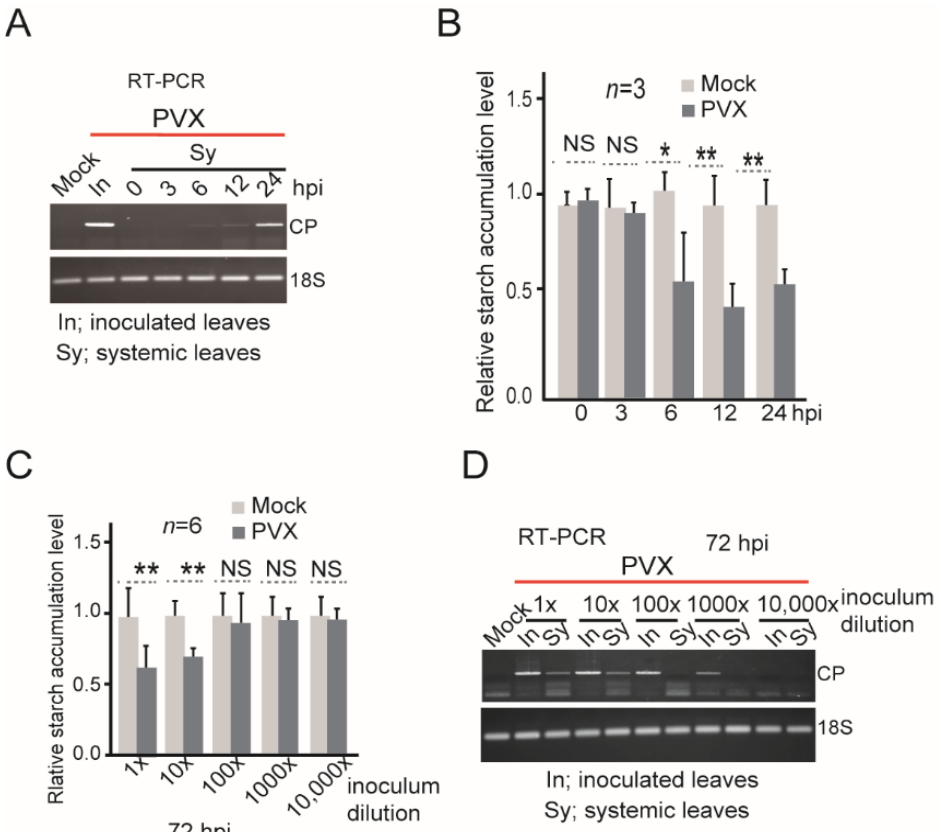
Figure 2. The sensitivity of virus detection method by assessing starch accumulation levels. ( A ) Time-course RT-PCR detection of PVX in upper leaves at 0, 3, 6, 12, and 24 h post inoculation (hpi). ( B ) Relative starch accumulation in the leaves described in ( A ). Data are presented as mean ± SD. The mock sample data value was set to 1.0. ( C ) Relative starch accumulation in the leaves of plants inoculated with 10-fold serially diluted PVX inoculum. Data are presented as mean ± SD. The mock sample data value was set to 1.0. ( D ) RT-PCR detection of PVX in the leaves of plants described in ( C ). “*”, and “**”, indicate a significant difference at p < 0.05, and 0.01, respectively. “NS” indicate no significant difference (Student’s t -test).